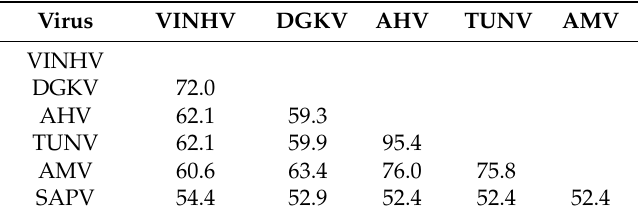
Table 2. Amino acid sequence identities (%) of the nucleoproteins of Dera Ghazi Khan genogroup viruses. Sequence identities were determined by p -distance estimation using MEGA7. Virus VINHV DGKV